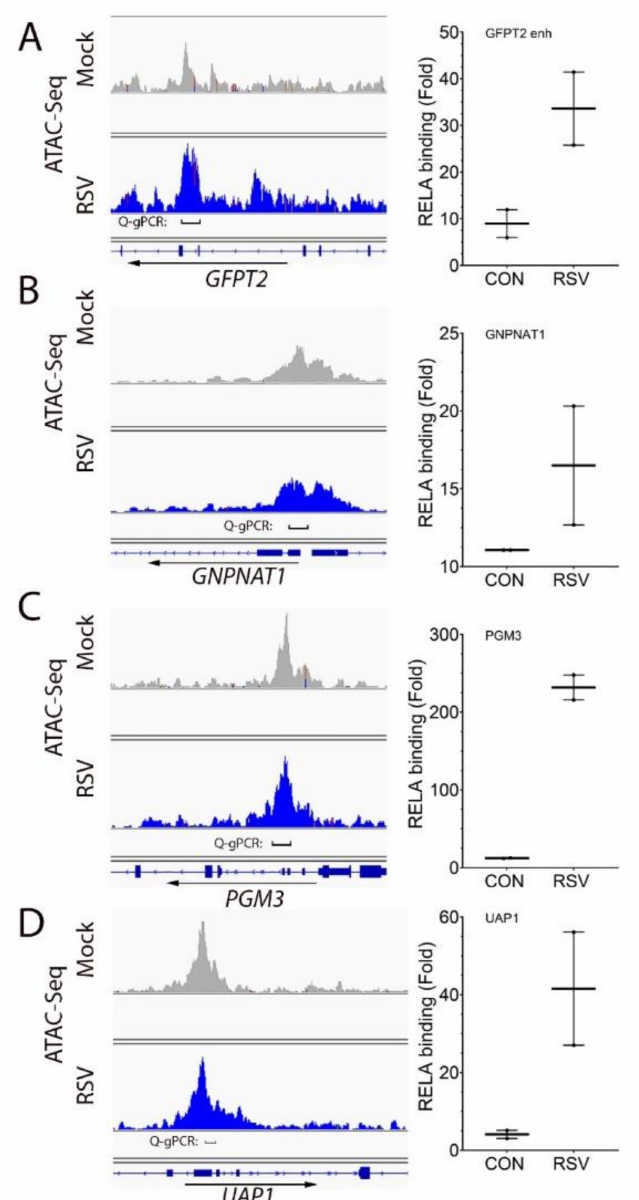
Figure 5. RELA binds to open chromatin domains in HBP core genes. For each gene (at left) is shown the chromatin accessibility determined by ATAC-Seq in uninfected (mock) or RSV-infected cells. The region assayed by Q-gPCR is indicated. The direction of gene transcription is indicated by arrow. At right is the Q-gPCR of mock- (CON) or RSV-infected cells analyzed by XChIP with RELA Ab. Each symbol is an independent immunoprecipitation. ( A ), GFPT2 ; ( B ), GNPNAT1 ; ( C ), PGM3 ; ( D ), UAP1